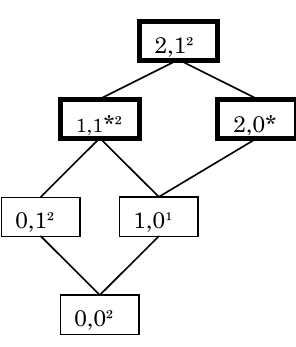
Fig. 7. Evaluation of attribute {c} based on reduct